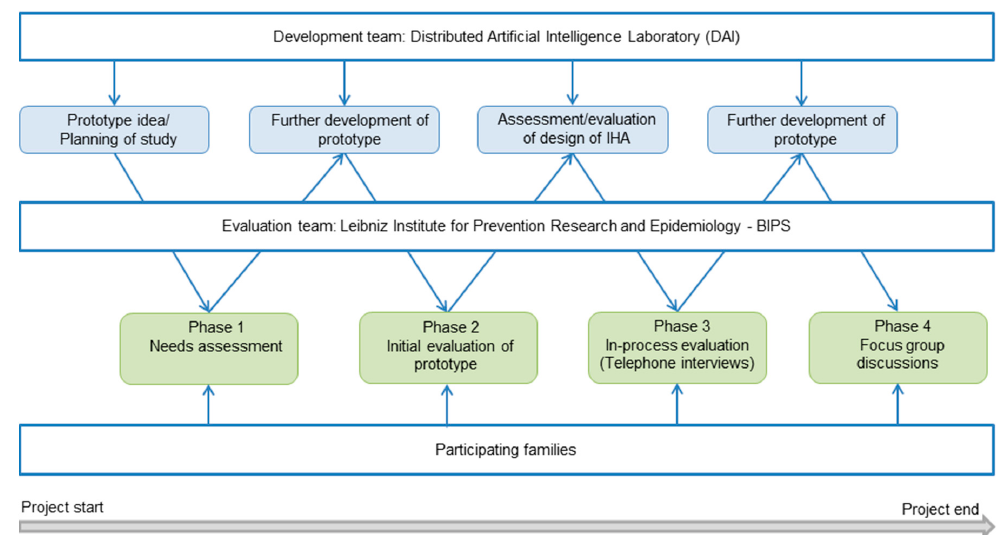
Figure 1. Development and evaluation process of the multilingual intelligent health assistant